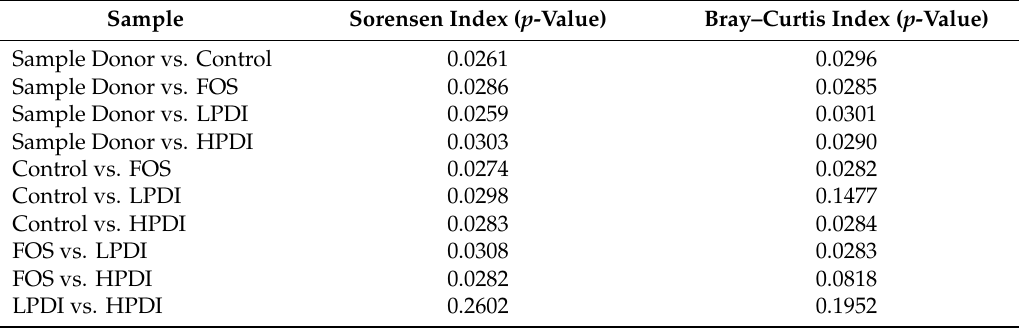
Table 1. Significance of the di ff erences between treatments based on pooled data from days 7 and 14, one-way ANOSIM using the Sorensen and Bray–Curtis indexes at the genus level. Reported p -values are nominal, and none of them held after the Bonferroni correction was applied. vs.—versus.